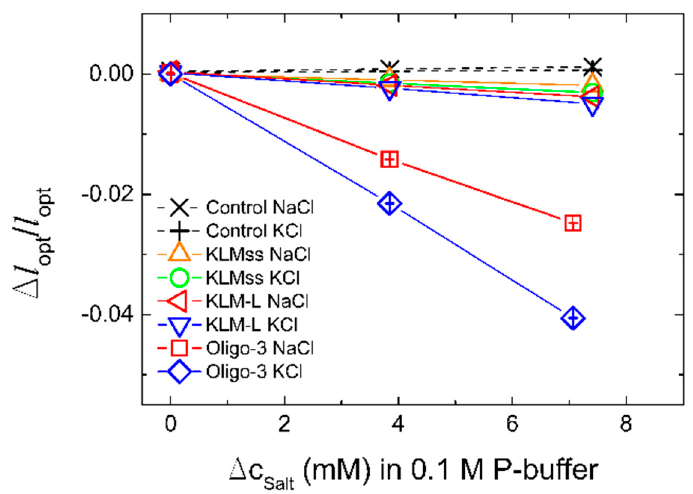
Figure 2. Sensitivity and selectivity of biosensor hydrogels incorporating either oligo-3, KLM-L, or KLMss oligonucleotides as a function of the K + and Na + ions, added to the 0.1 M phosphate buffer (pH 7.4) in two steps. The sensitivity was determined as the relative change in optical length of the hydrogels when they are changing their extent of swelling as function of salt concentration for Na + and K + . Acrylamide gel with corresponding concentrations of acrylamide and numbers of crosslinks, without incorporated DNA sequences, is used as the control. The standard deviation of ∆ l opt / l opt for the oligo-3-co-AAm hydrogel sensor are shown at 0, 3.8 and 7.1 mM of NaCl and KCl added to the phosphate buffer.